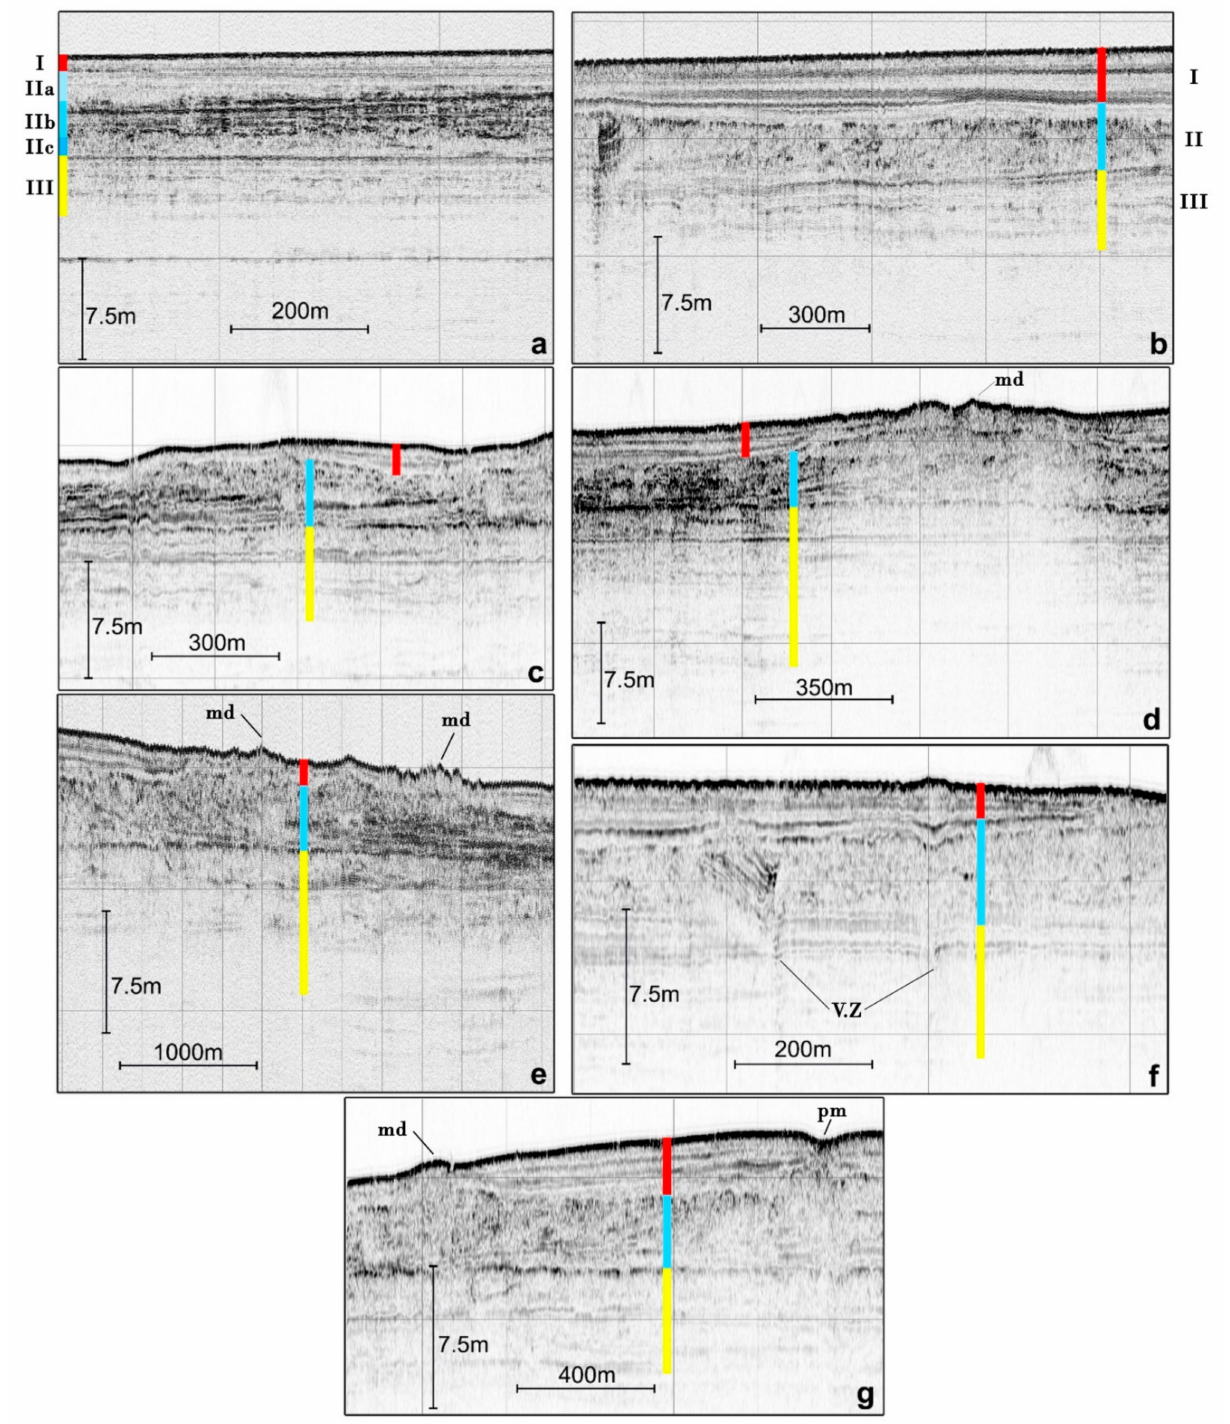
Figure 5. Chirp seismic reflection profiles collected from the study area showing ( a ) specific acoustic characteristics of the three acoustic sequences (I, II, III). ( b , c ) The middle sequence II consists of a sediment body of chaotic seismic reflections with locally very disturbed reflectors and acoustic transparent zones, ( d , e ) sequence II locally subcrops and finally outcrops the seabed, forming small mounds (md), ( f ) vertical zones (vz) of seismic anomalies within the chaotic sequence II and the underlying III, and ( g ) negative (pockmarks? pm) and positive (mounds,